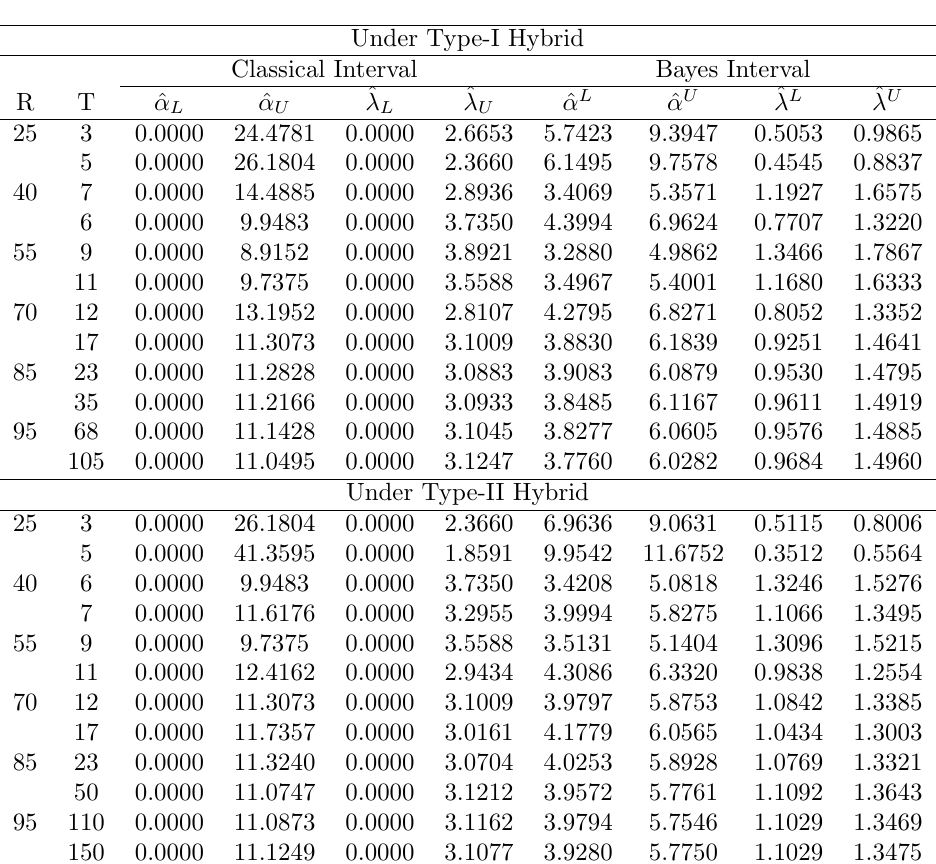
Interval estimates of the parameters for the simulated data set for different variation of R and T